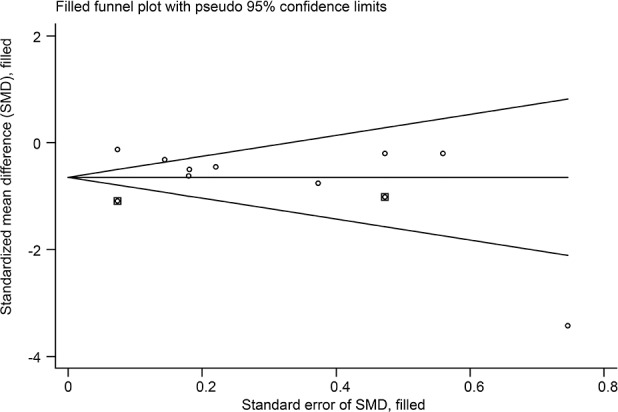
Metatrim Funnel Plot of Acupuncture versus Sham-acupuncture for CLBP in Pain at immediate term.The dots in the squares were the studies filled. There were two trials with positive effects filled.